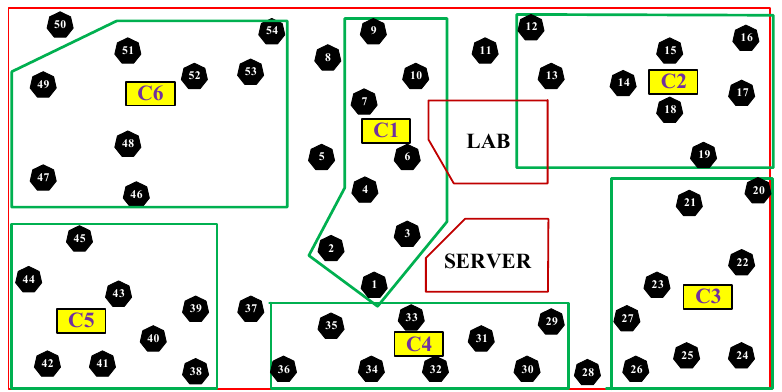
Figure 7. The cluster structure of deployed sensors